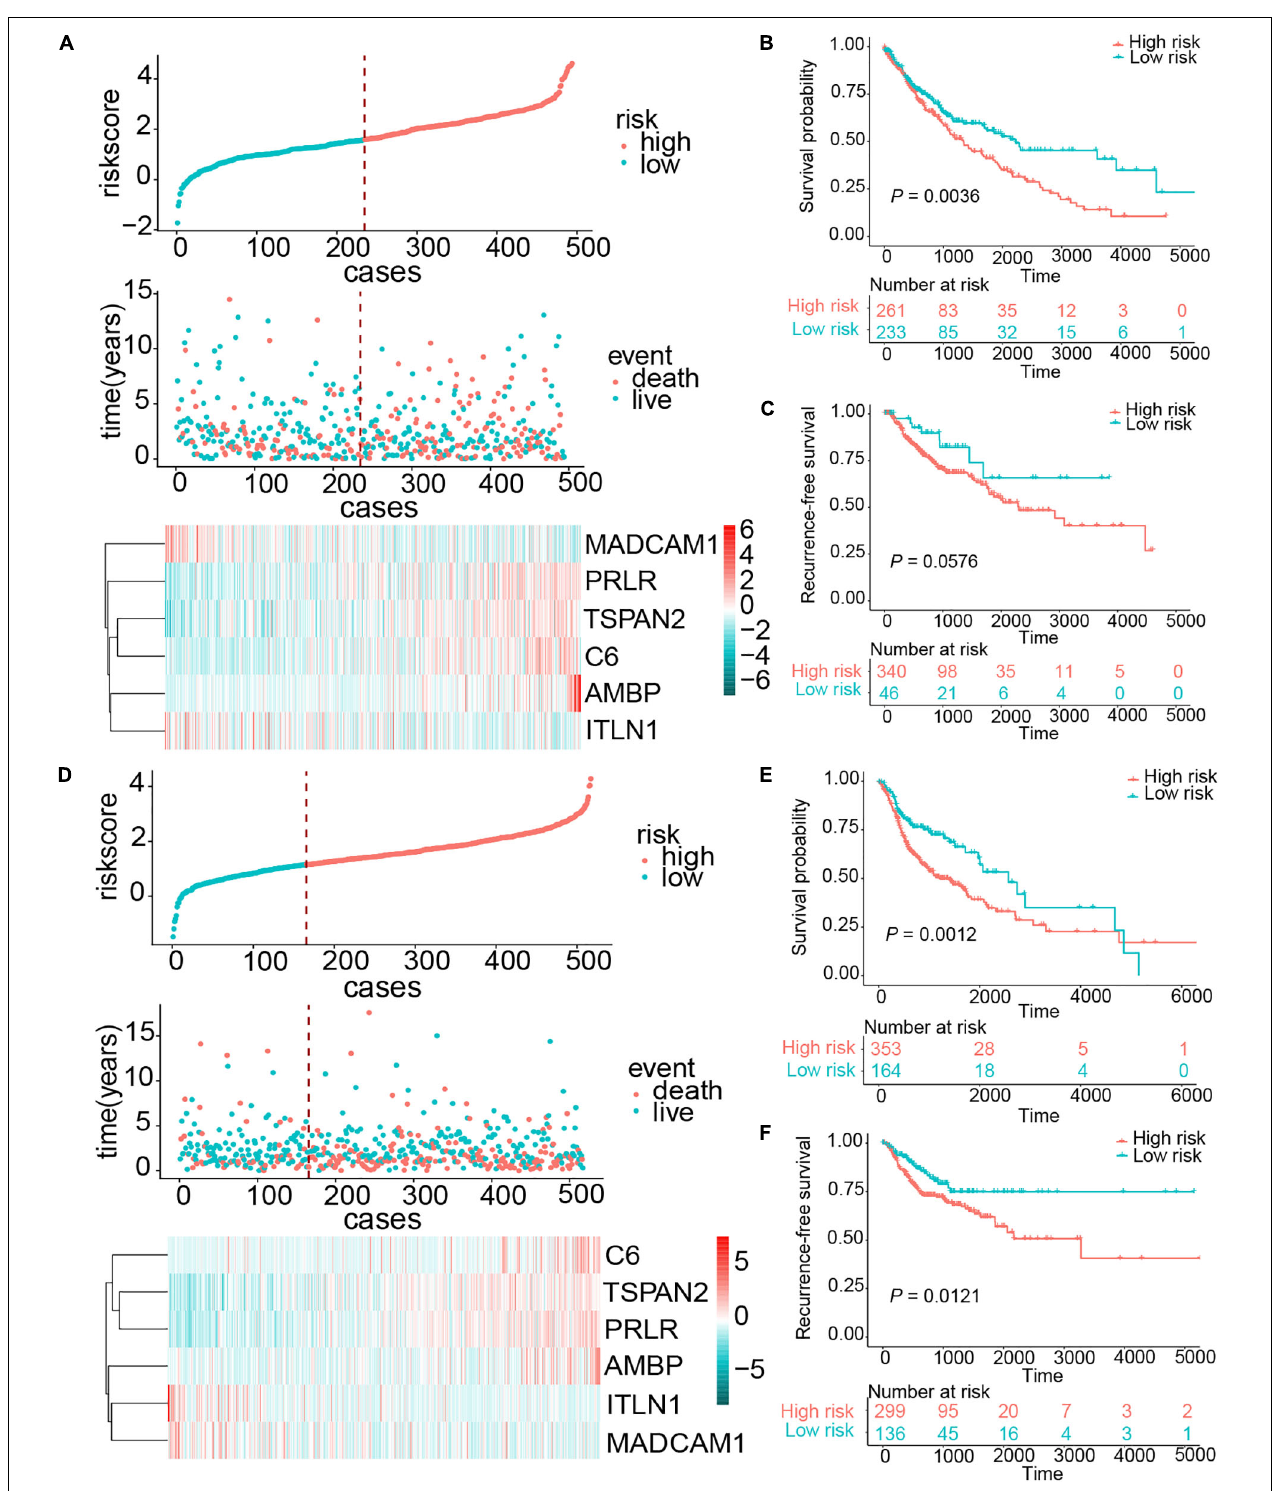
FIGURE 7 | Risk score distribution and survival of patients in the LUSC and HNSCC cohorts. (A) The risk scores for 494 patients of the LUSC cohort, the survival of each patient, and gene expression distribution in the LUSC cohort. (B,C) Kaplan–Meier curve of OS and RFS in the LUSC cohort, respectively. (D) The risk scores for 517 patients of the HNSCC cohort, the survival of each patient, and gene expression distribution in the HNSCC cohort. (E,F) Kaplan–Meier curve of OS and RFS in the HNSCC cohort, respectively.